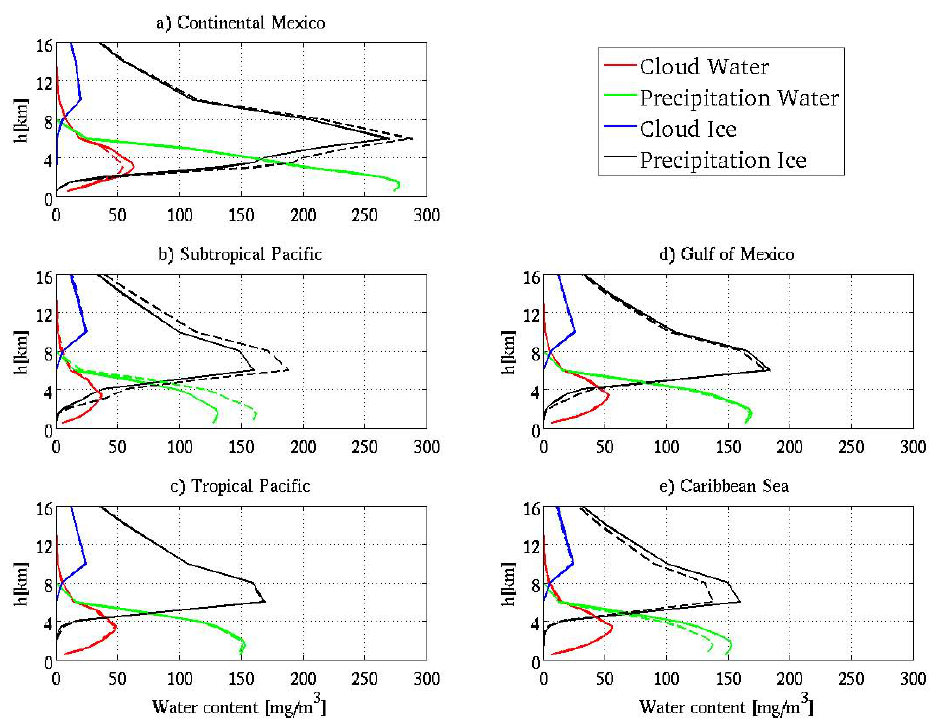
Fig. 4. Vertical profiles of hydrometeors in precipitating clouds averaged over four summer months (June to September) for the period 2005– 2009, and spatially averaged over the regions shown in Fig. 1. Solid lines correspond to daytime profiles (06:00a.m.–06:00p.m.) and dashed lines correspond to nighttime profiles (06:00p.m.–06:00a.m.).